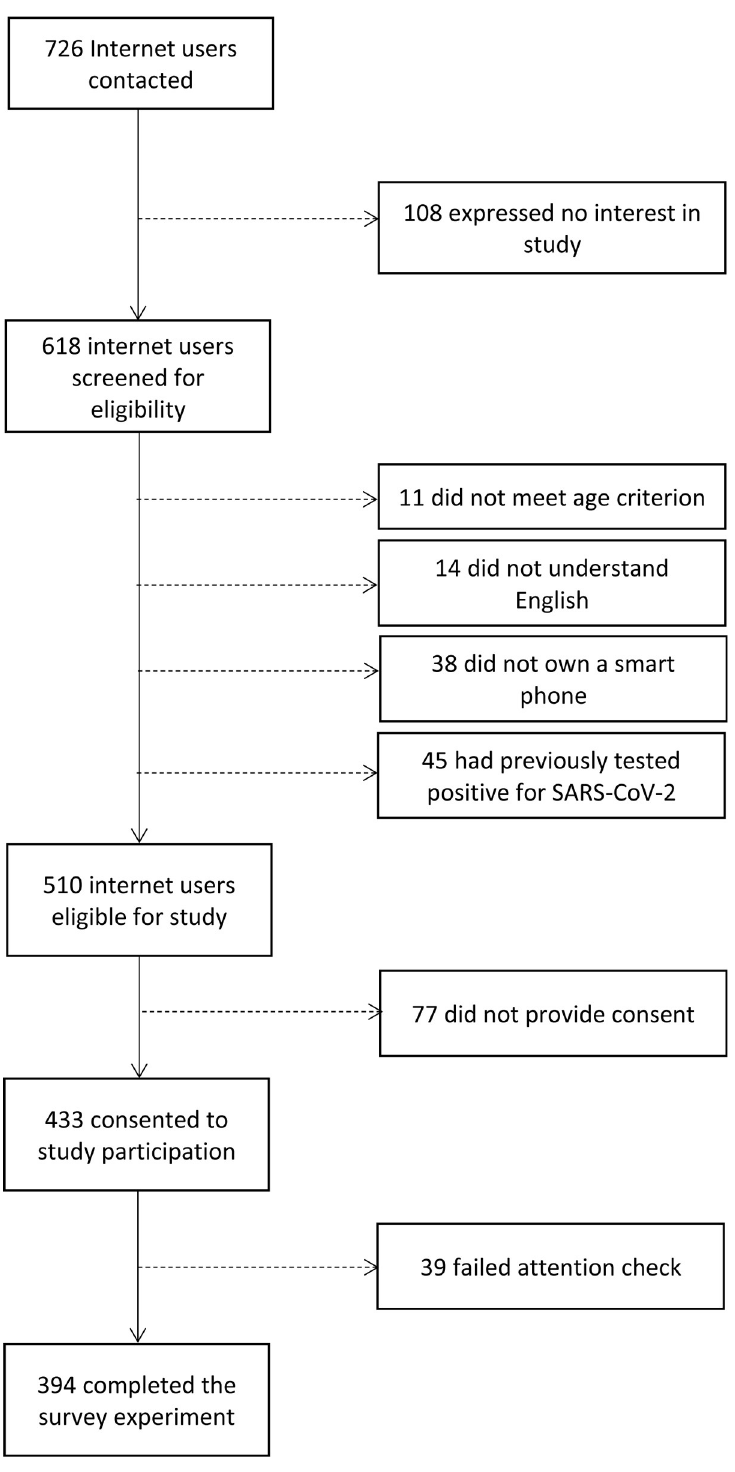
Fig 1. Flow chart of the study enrollment